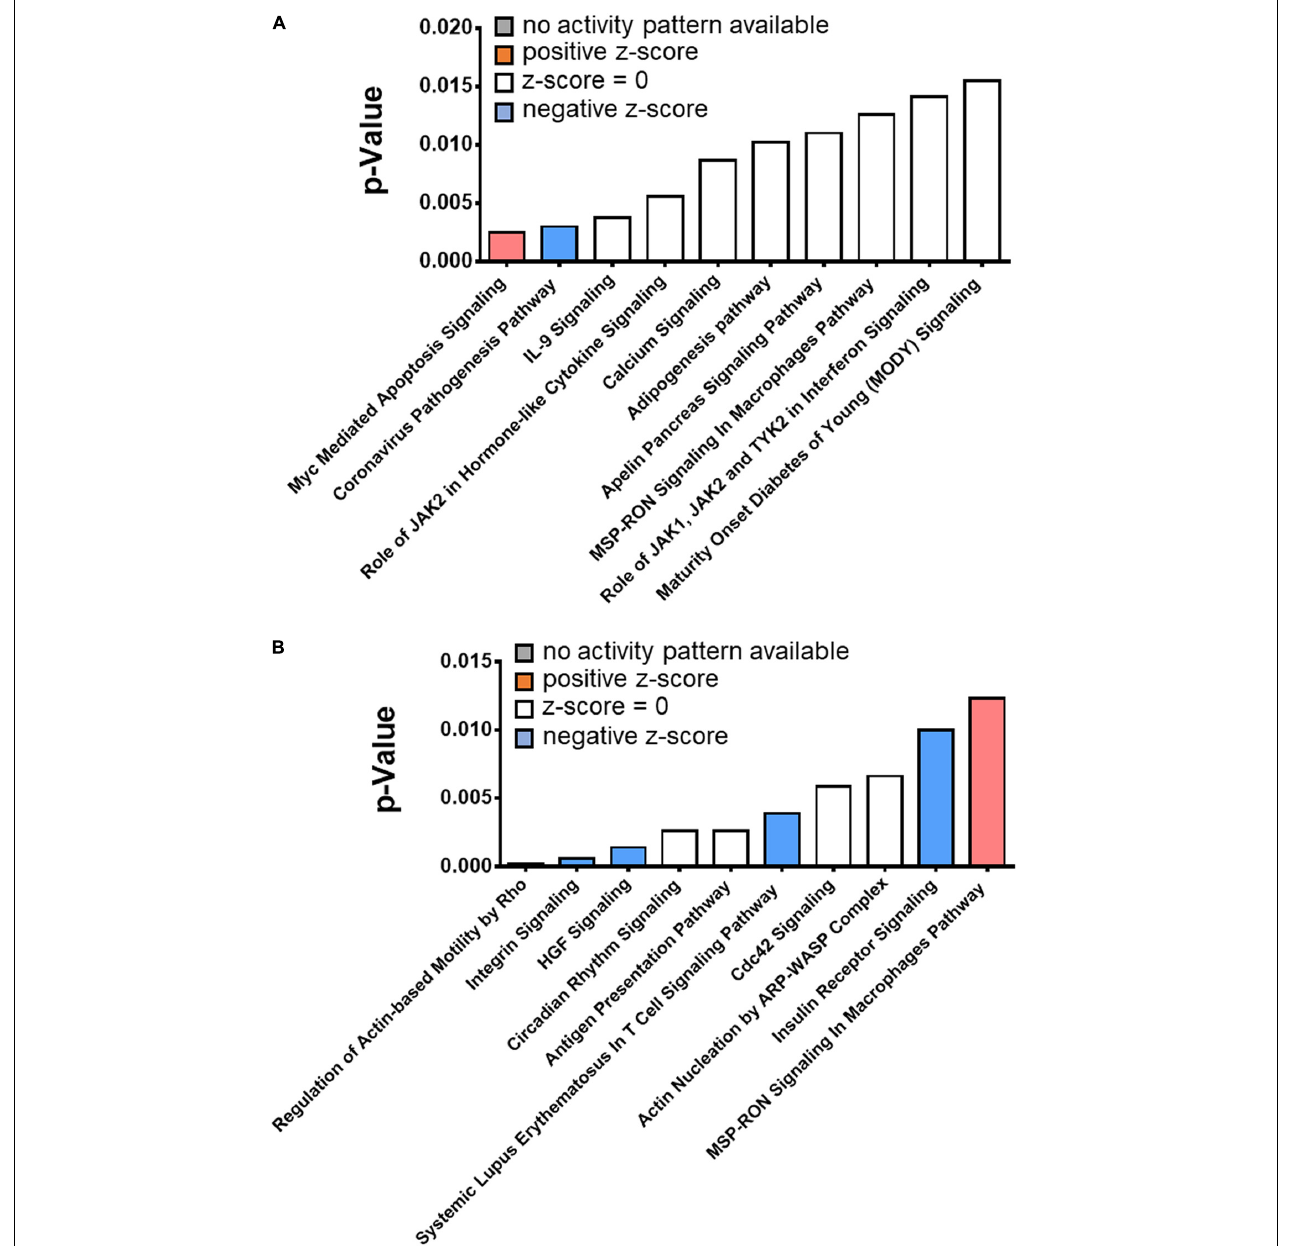
FIGURE 6 | Top significantly altered pathways in the heart of CONV and GF mice following intermittent hypoxia/hypercapnia exposure. The canonical pathways that were significantly altered by IHH exposure in CONV and GF mice were determined with IPA. (A) The top 10 significantly altered pathways in CONV mice. (B) The top 10 significantly altered pathways in GF mice. The statistical significance was calculated with right-tailed Fisher’s exact test; a p -value < 0.05 was considered significant.